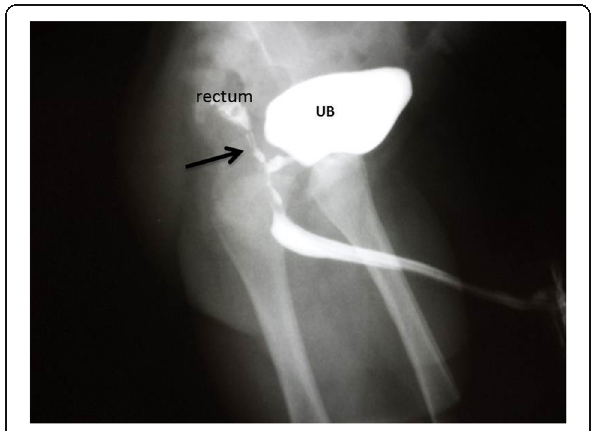
Fig. 11 Recto-urethral (prostatic) fistula in an infant. Ascending cysto-urethrogram showing the fistulous tract (arrow) between the rectum and the prostatic